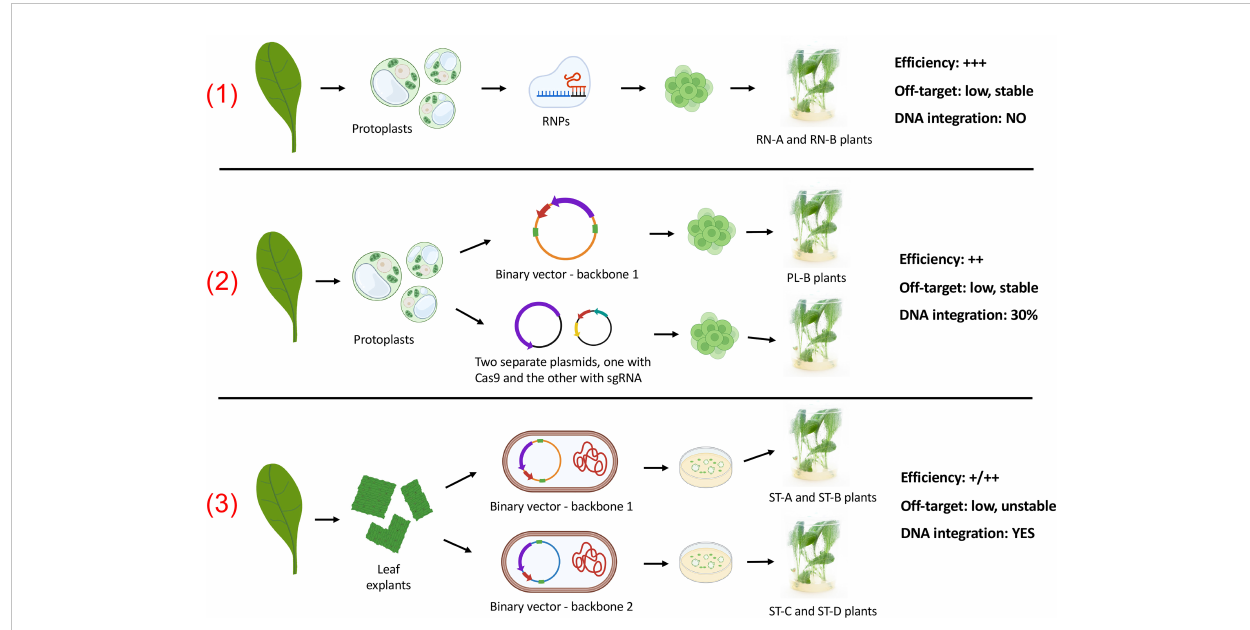
FIGURE 1 Scheme of the three CRISPR/Cas9 delivery methods as they are referred to in the main text and summary of their main outcome. The nomenclature adopted for the resulting plants is shown. Method 1: Stable integration of T-DNA containing CRISPR/Cas9 components, using two binary vectors with a different backbone. Method 2: transient expression of CRISPR/Cas9 components after protoplast transfection with one or two plasmids. Method 3: transient transfection of protoplasts directly with RNPs (DNA-free method). The purple arrow in the plasmids indicates Cas9 gene, the red arrow indicates the common guide RNA, and the green blocks indicate the Right and Left Borders (to highlight which vectors were binary and which were